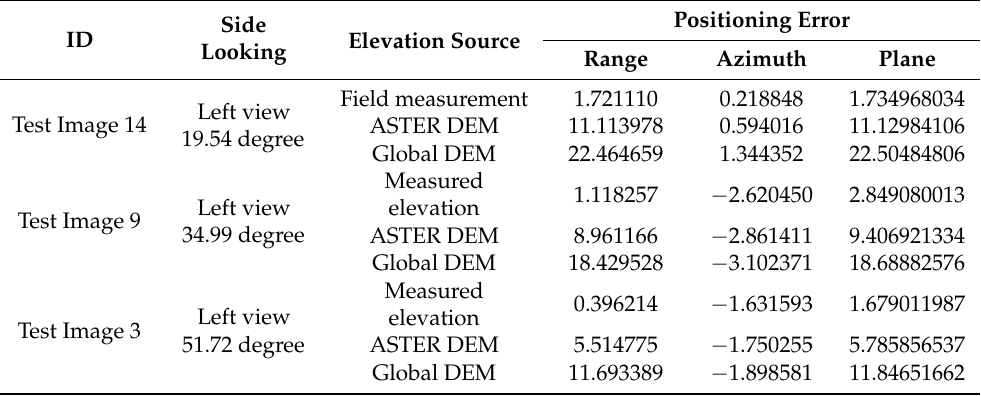
Table 6. Positioning accuracy of different side-looking angles under different precision DEM.